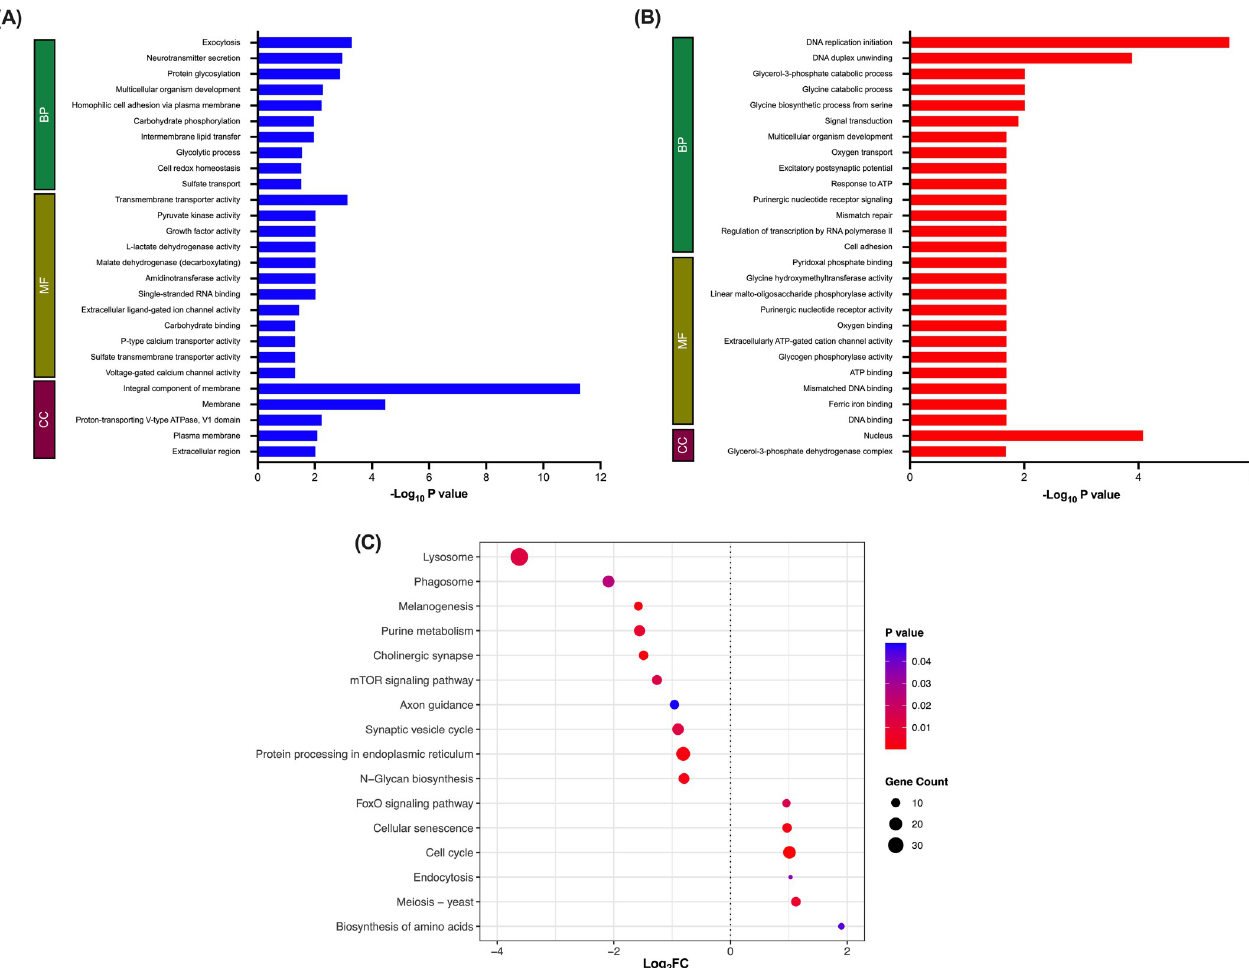
Fig 3. In vitro juvenile fluke display enhanced expression of genes required for cell signalling and in vivo juvenile fluke display enhanced expression of genes associated with the cell cycle. (A) TopGO analysis of genes downregulated in vivo . (B) TopGo analysis of genes upregulated in vivo . mRNA GO term enrichment was analysed via topGO [36] where FDR < 0.05, method = weight01 and statistic = fisher. (C) KEGG pathway analysis of differentially expressed genes. KEGG pathways considered significantly differentially expressed as determined by statistical analysis using R (v.3.6.2), gage (v.2.36.0) and pathview (v.1.26.0) packages (P � 0.05). Dotted line = 0 log 2 FC; dots to the right of dotted line represent pathways upregulated in vivo and dots to the left of the dotted line represent pathways downregulated in vivo . Colour = p value; size = gene